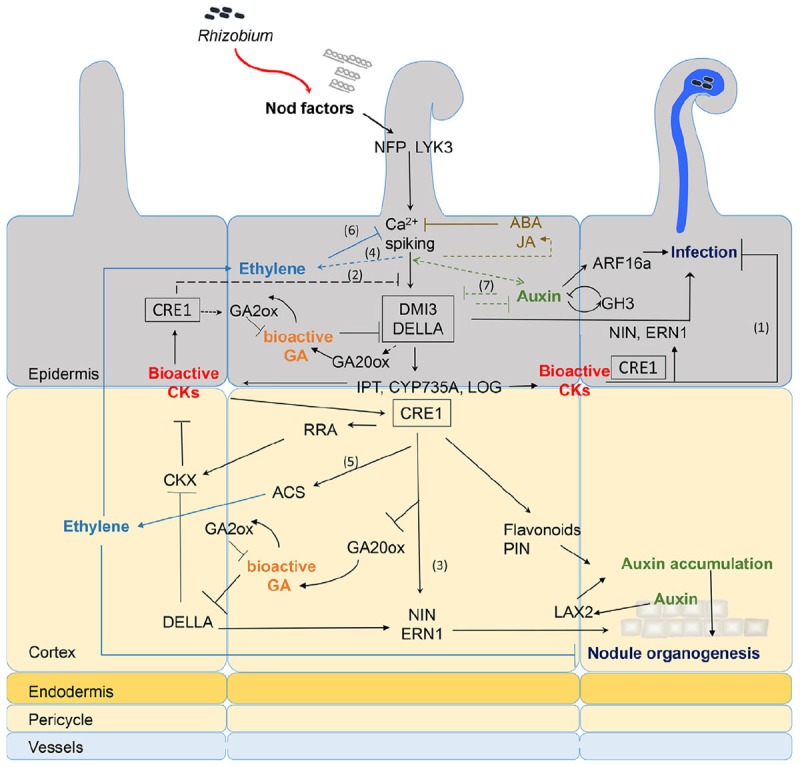
Recapitulative spatio-temporal scheme of the interactions between NF signaling and downstream hormonal pathways. Rhizobia produce NFs that are perceived in root hairs (RHs) through LysM-RLK receptors such as NFP and LYK3. NF perception leads to calcium spiking and activation of DMI3 that acts upstream of the CK receptor MtCRE1. The signaling cascade involving DMI3 and CRE1 is likely involved in both epidermal and cortical signaling (black boxes). NF treatment triggers early CK biosynthesis gene (IPT/CYP735A/LOG) expression and CK accumulation in M. truncatula roots downstream of DMI3 but independently of CRE1 signaling (van Zeijl et al., 2015b). Although tissue specificity of this CK production was not determined, evidence from L. japonicus and M. truncatula suggests that epidermal CK accumulation is a negative regulator of RH infection (1) and NF signaling (2) (Held et al., 2014; Jardinaud et al., 2016). In contrast, cortical CK is a positive regulator of nodule organogenesis (3) (Gonzalez-Rizzo et al., 2006; Murray et al., 2007; Reid et al., 2017). Bioactive CKs are perceived by CRE1 and induce expression of NIN and ERN1 (Ariel et al., 2012), which are positive regulators of both infection and nodule organogenesis (Andriankaja et al., 2007; Marsh et al., 2007). This induction might be partly through regulation of DELLA activities. GA is a negative regulator of DELLA protein stability. Bioactive GA pools are likely present in both epidermis and cortex early after NF treatment (Fonouni-Farde et al., 2016; Jardinaud et al., 2016; Herrbach et al., 2017). DELLAs play a positive regulatory role on symbiotic gene expression such as ERN1 and they negatively regulate CK degradation (Fonouni-Farde et al., 2016, 2017; Jin et al., 2016). In contrast, CK positively regulate GA inactivation enzymes and down-regulate expression of the GA20ox activation enzyme (Fonouni-Farde et al., 2018), suggesting a negative feedback of CK on GA active pools. NF signaling induces ethylene production, both independently of the LHK1/CRE1 CK pathway (4) (Reid et al., 2018) and downstream of CK perception (5) (van Zeijl et al., 2015b). Ethylene reduces CK production in M. truncatula roots, possibly through negative feedback on NF signaling (6) (van Zeijl et al., 2015b). Ethylene negatively regulates NF-induced calcium spiking, RH infection, and nodule organogenesis (Heidstra et al., 1997; Penmetsa et al., 2008). Regulation of auxin biosynthetic and conjugation enzyme (GH3) genes occurs in NF treated RHs and upon S. meliloti inoculation in an NF-dependent manner (Breakspear et al., 2014; Larrainzar et al., 2015; Jardinaud et al., 2016; Herrbach et al., 2017). Reciprocal positive and negative feedback regulatory loops between some auxin and NF regulated genes (7) was shown by comparing the combined effect of auxin and NFs to either treatment alone (Herrbach et al., 2017). Downstream of CK perception, control of auxin transport in the cortex seems regulated by differential expression of PIN genes (Plet et al., 2011) or accumulation of flavonoid compounds. Auxin accumulation is also mediated by MtLAX2 that is induced upon S. meliloti infection in vasculature and early nodule primordia, and which is required for nodule organogenesis (Roy et al., 2017). In parallel, epidermal auxin signaling controls infection thread (IT) formation, at least partly through ARF16a (Breakspear et al., 2014). Exogenous application of high concentrations (μM range) of ABA or JA inhibits NF-induced calcium spiking (Sun et al., 2006; Ding et al., 2008) but this inhibition is so far not supported by any transcriptomic data. Plain bars represent negative and plain arrows positive regulations. Dashed lines are hypothetical relationships, and solid lines have evidence from the literature. Different hormones are highlighted by different colors. CK, cytokinins; GA, gibberellins; ABA, abscisic acid; JA, jasmonic acid; NF, Nod factors. Bacteria entrapped in curled root hair and IT are shown in blue.